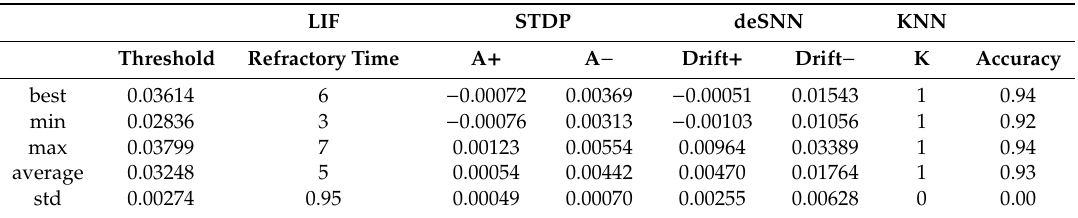
Figure 4. The optimization process of the parameters of the SNN model showing the accuracy obtained over 80 iterations. Table 2. The values of the seven SNN parameters and their corresponding classification performance obtained as a result of the DE optimization process.